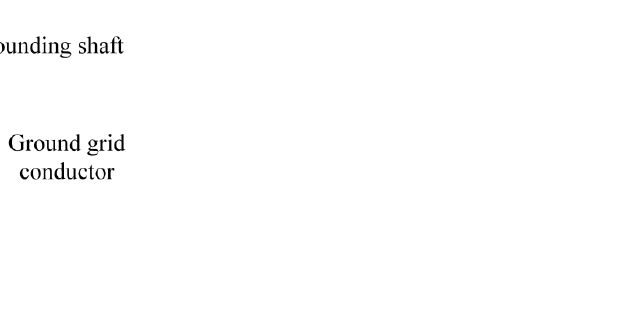
Figure 1. Structure of the ground network of the VLF umbrella-type transmitting antenna.